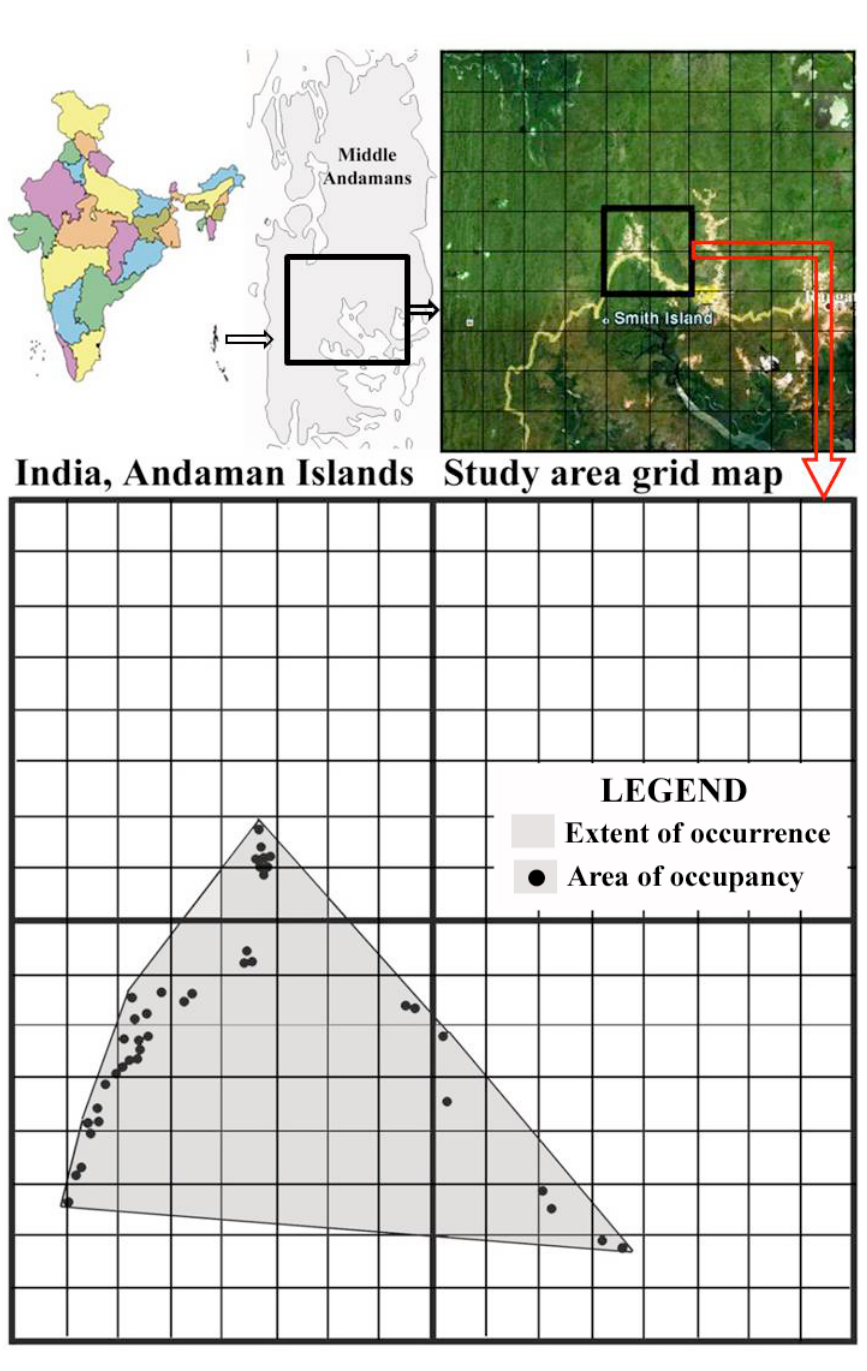
Figure 1. Minimum convex polygon of Dendrobium